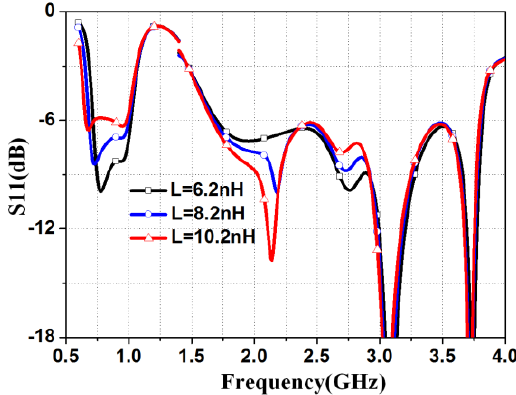
Figure 4. Simulated S11 with different values of L.